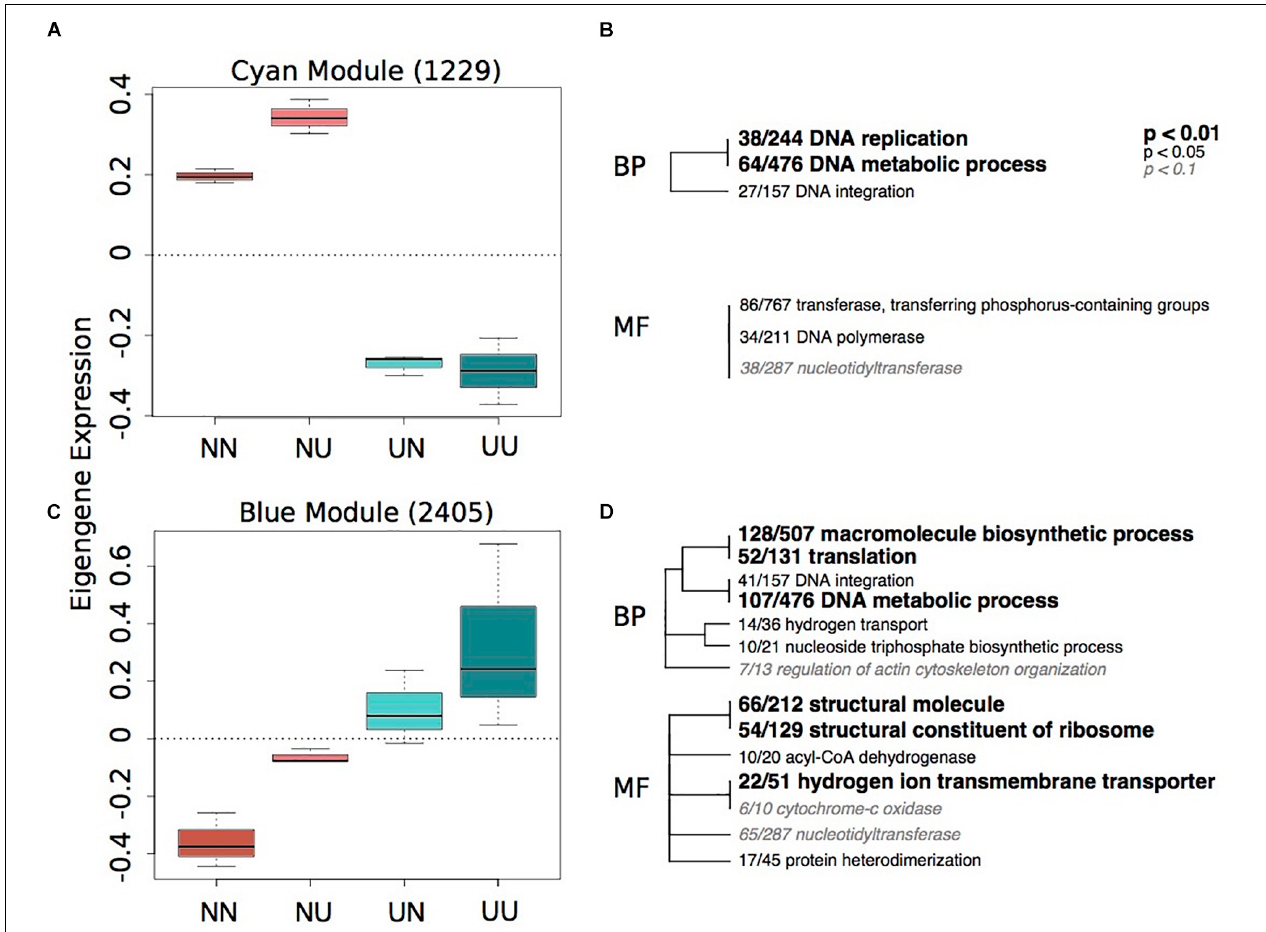
FIGURE 3 | Gene expression modules strongly correlated to maternal environment. Boxplots of eigenegene expression for the cyan (A) and blue (C) modules. The number of genes represented in each module is in parentheses. Hierarchical clustering of Gene Ontology (GO) terms showing significant enrichment in the cyan (B) and blue (D) modules. Level of significance indicated with bold text. BP, biological processes; MF, molecular function.